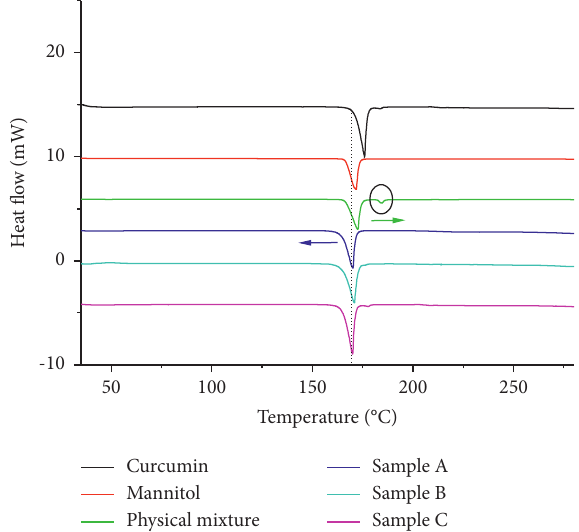
Figure 4: DSC curves of spray-dried samples, raw materials, and physical mixture.